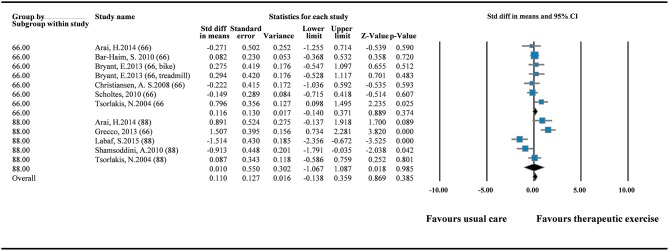
Forest plot of pairwise comparison between therapeutic exercise and standard care (overall GMFM). I2 = 0%; Q = 10.139; df = 11.